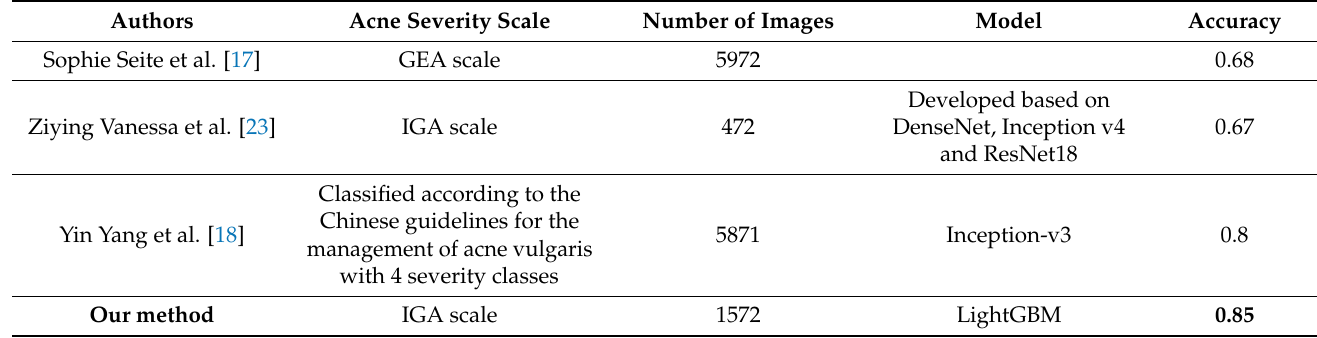
Table 7. Comparison of accuracy in grading acne severity obtained through our study and in previous